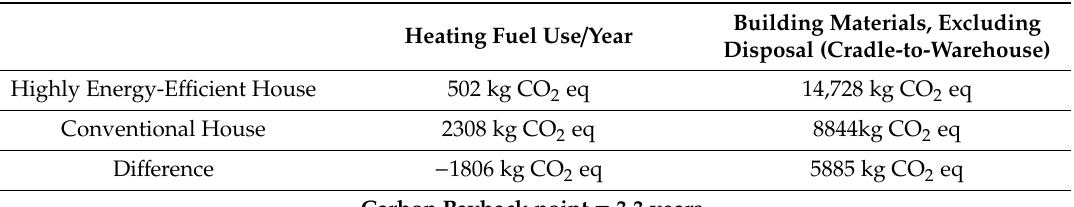
Table 2. Carbon payback for the additional building materials used in the highly energy-e ffi cient house. Heating Fuel Use /